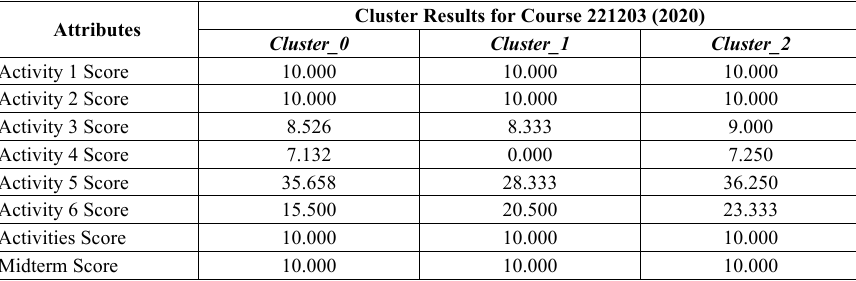
Table 8. Cluster results for course 221203